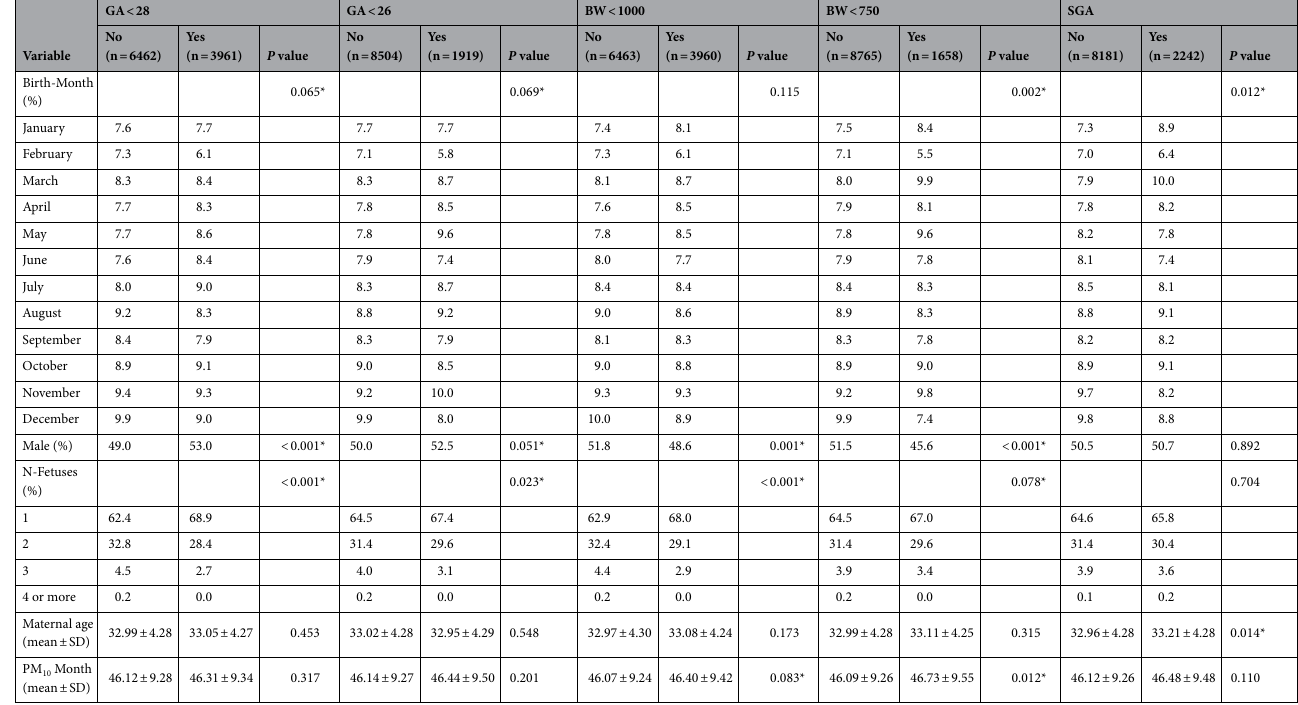
Table 2. Univariate analysis. BW, birth weight (grams); GA, gestational age (weeks); N-fetuses, number of fetuses, PM, particulate matter; SGA, small-for-gestational age. * P < 0.10 chi-square test for the equality of proportions “Yes” or T test for the equality of means.